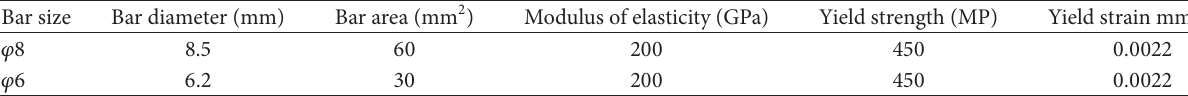
Table 2: Mechanical properties of reinforcing bars.